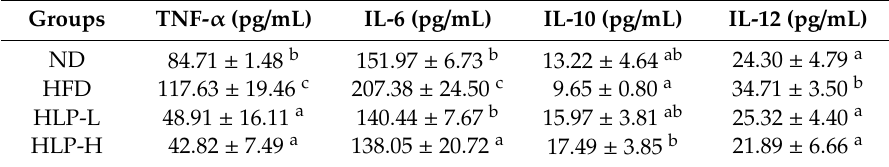
Table 1. HLP had different effects on suppressing the chronic inflammation caused by HFD. Table 1. HLP had di ff erent e ff ects on suppressing the chronic inflammation caused by HFD. Groups